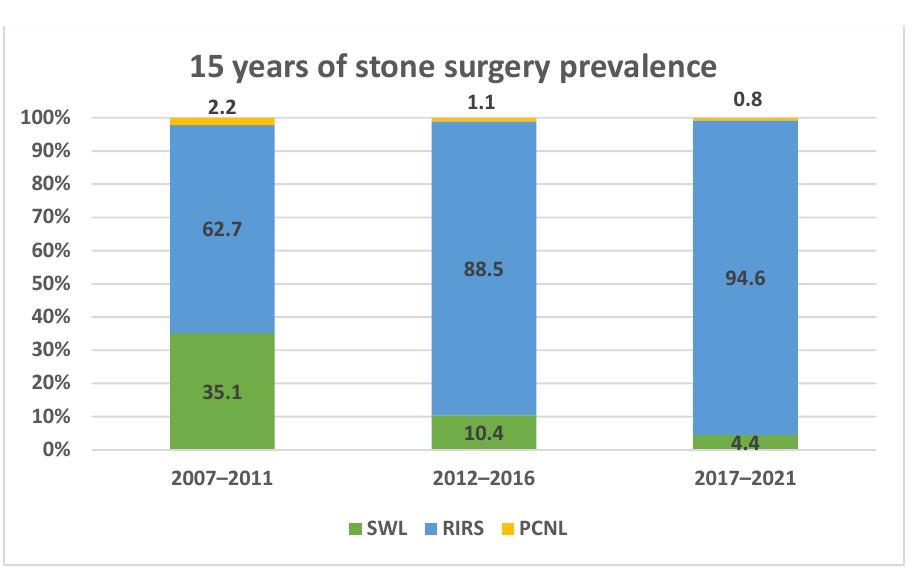
Figure 1. Stone surgery prevalence (%) after 15 years. SWL = shock wave lithotripsy; URS/RIRS = retrograde intrarenal surgery; PCNL = percutaneous nephrolithotomy.